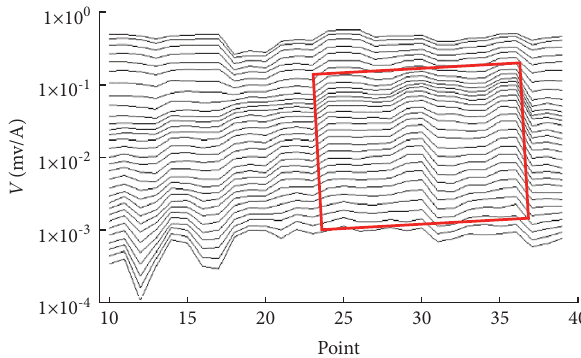
Figure 9: Multichannel voltage profile of test